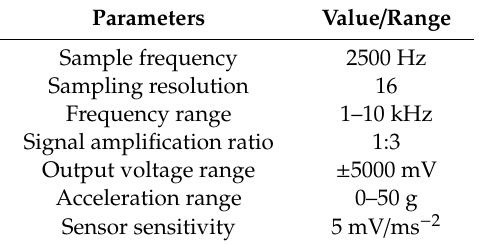
Figure 8. Experimental setup. ( a ) The SLK3661W vibrating screen applied in the coal washery. ( b ) Acceleration sensors and data acquisition instruments used in experiments. The main parameters of data acquisition are shown in Table 4. Table 4. The main parameters of data acquisition.